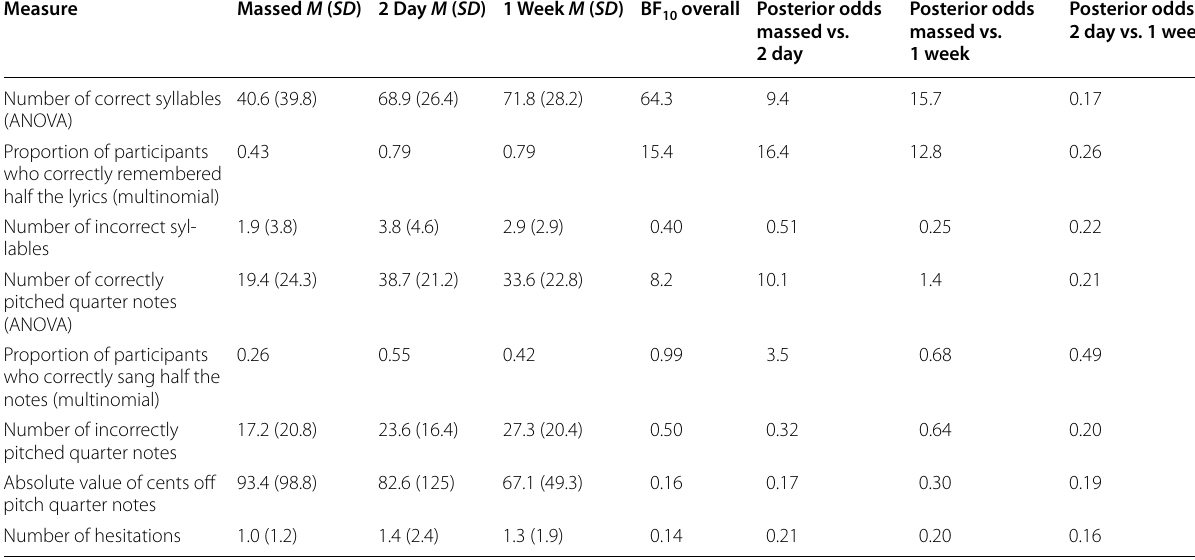
Table 4 Spacing effects at test 3.2